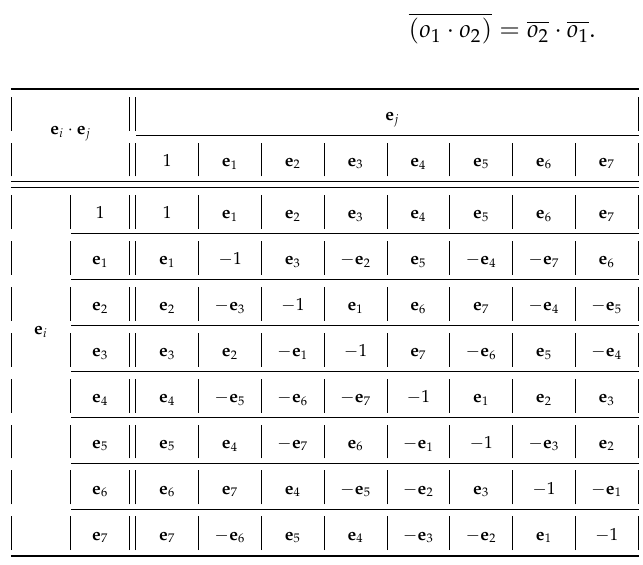
Figure 1. Multiplication rules in octonion